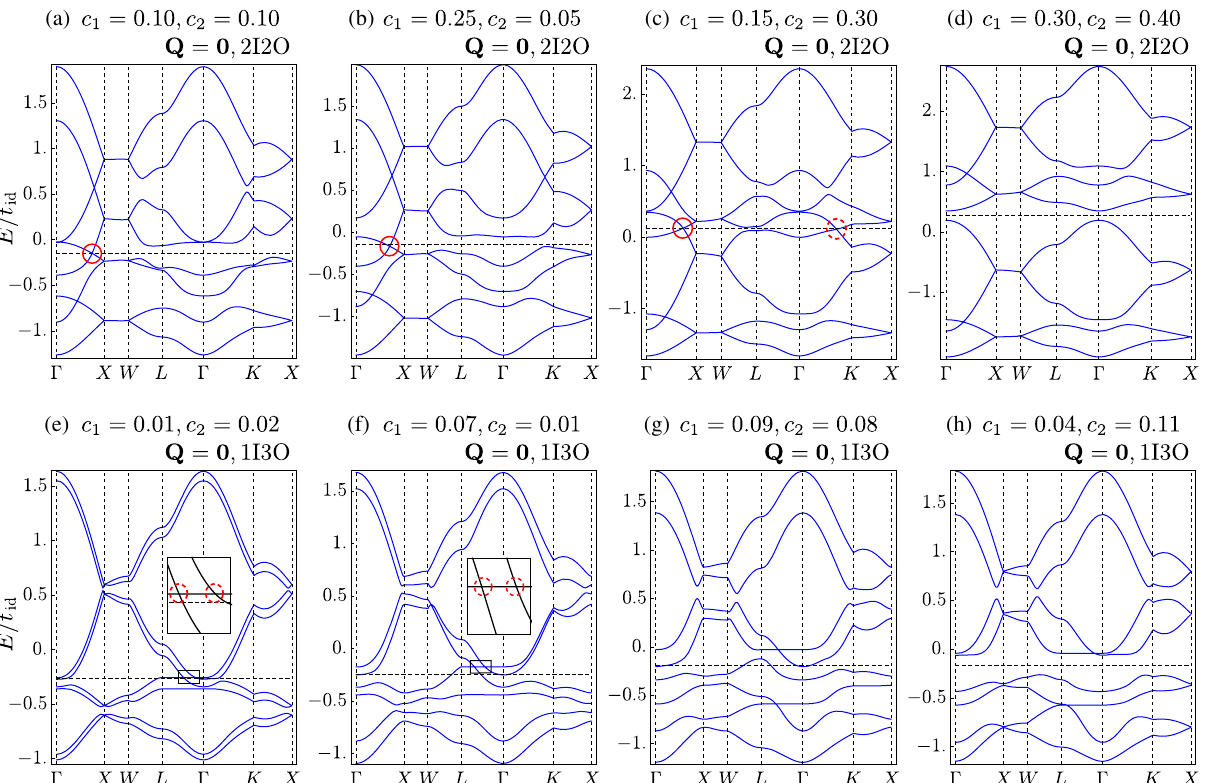
FIG. 6. Evolution of the Ir band structure as a function of f - d exchange parameters for (a) – (d) 1-in – 3-out (1I3O) and (e) – (h) 2-in – 2- out (2I2O) Pr magnetic states with Q ¼ 0 from Fig. 5(a). The dashed (solid) circle marks the usual (double) Weyl node. In (a) and (b), one band from L to Γ is flat. This is accidental for the nearest-neighbor hopping model and is dispersive if further neighbor hoppings are included [16]. In (g), the Weyl nodes are actually at different energies. The energy unit in the plots is t Fermi energy.